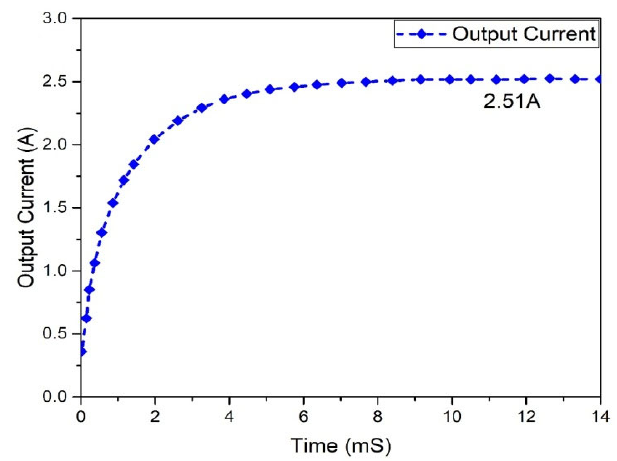
Figure 17. Results analysis of output current of interleaved boost converter.